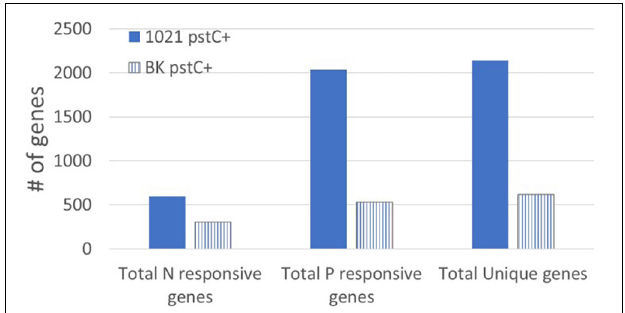
FIGURE 5 | Genes responding to nitrogen and phosphate stress in the BK pstC + strain. The total number of genes responding to nitrogen stress (left) and phosphate stress (center) in the 1021 pstC + (solid bars) and BK pstC + (striped bars) strains. The total number of unique genes (right) that changed in response to at least one nutrient stress is also shown for each